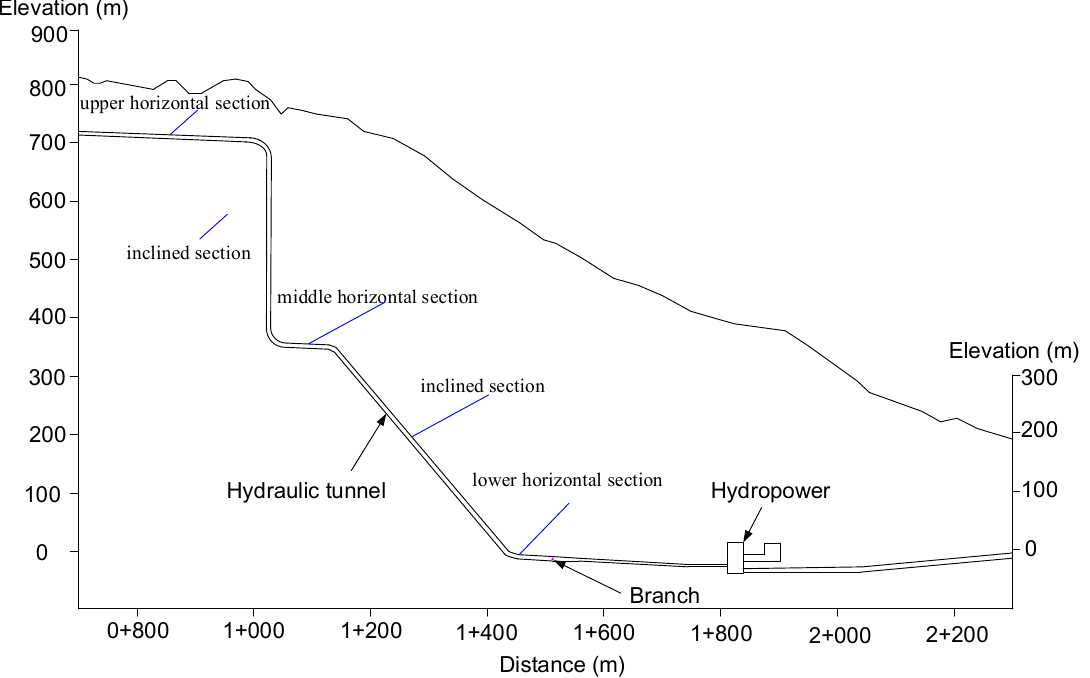
Figure 3. Layout of the diversion tunnel in the Yangjiang pumped-storage power station.